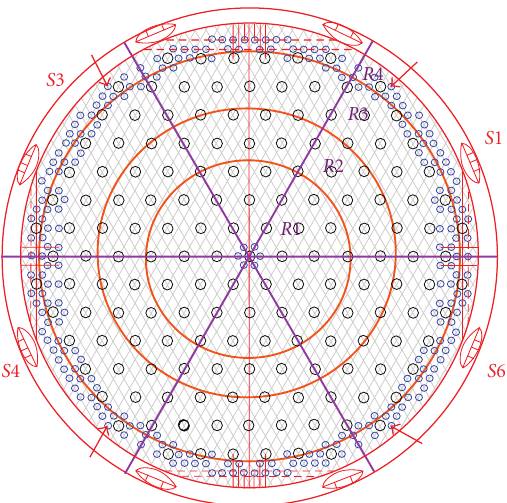
Figure 8: TRACE radial and azimuthal subdivision of the